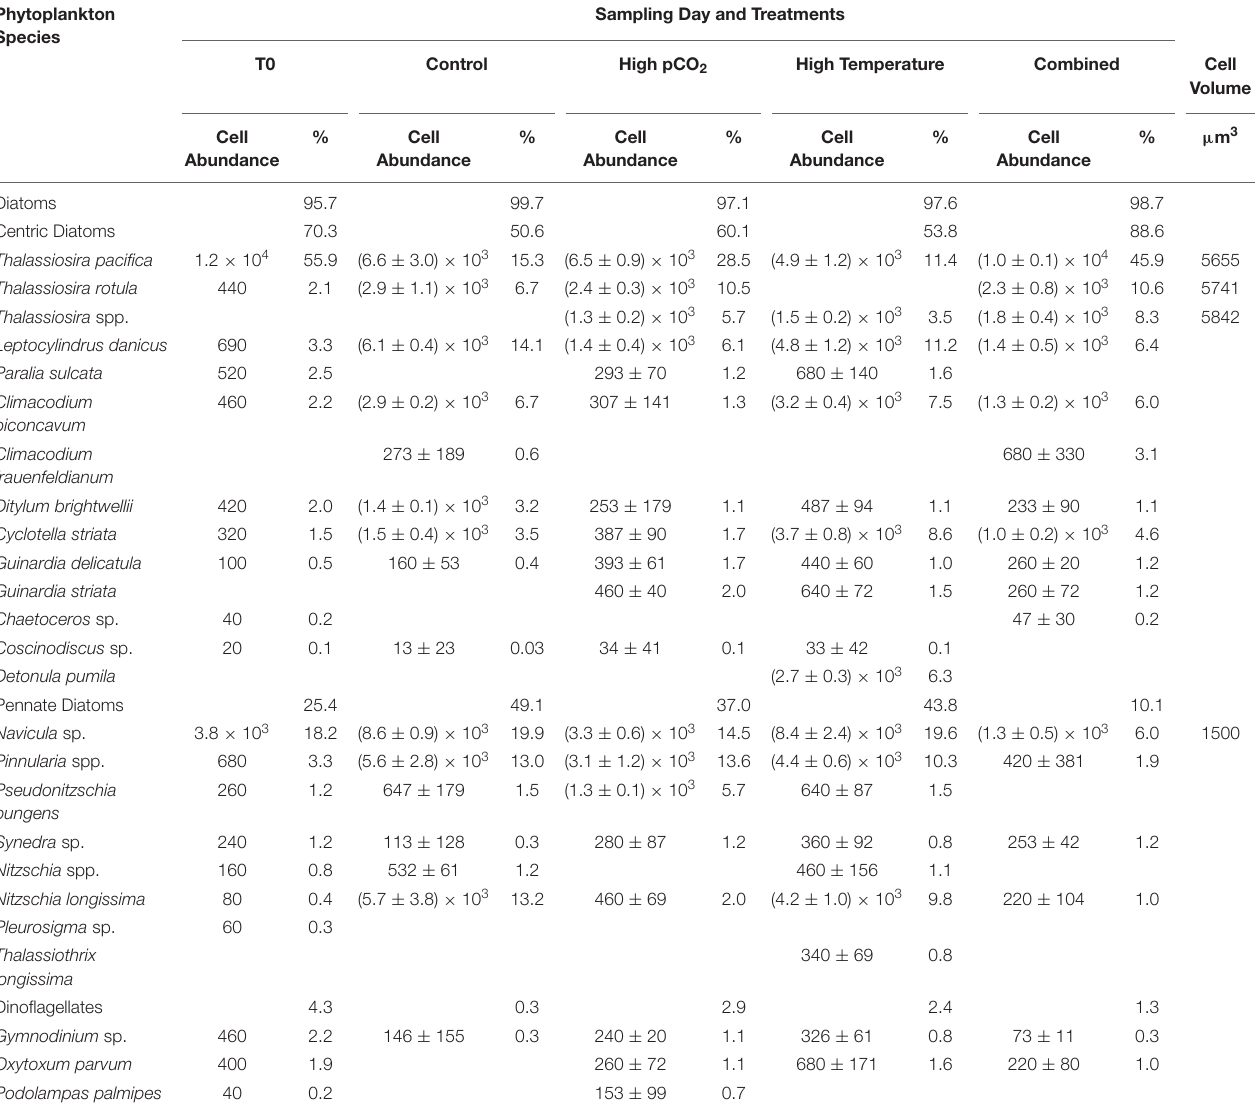
TABLE 1 | List of all diatom and dinoflagellate species and the cell abundances (cells L − 1 ) identified with microscopy on T0 and the four experimental treatments on the final sampling day and cell volume of the dominant species. Phytoplankton Sampling Day and Treatments Species T0 Control High pCO 2 High Temperature Combined Cell